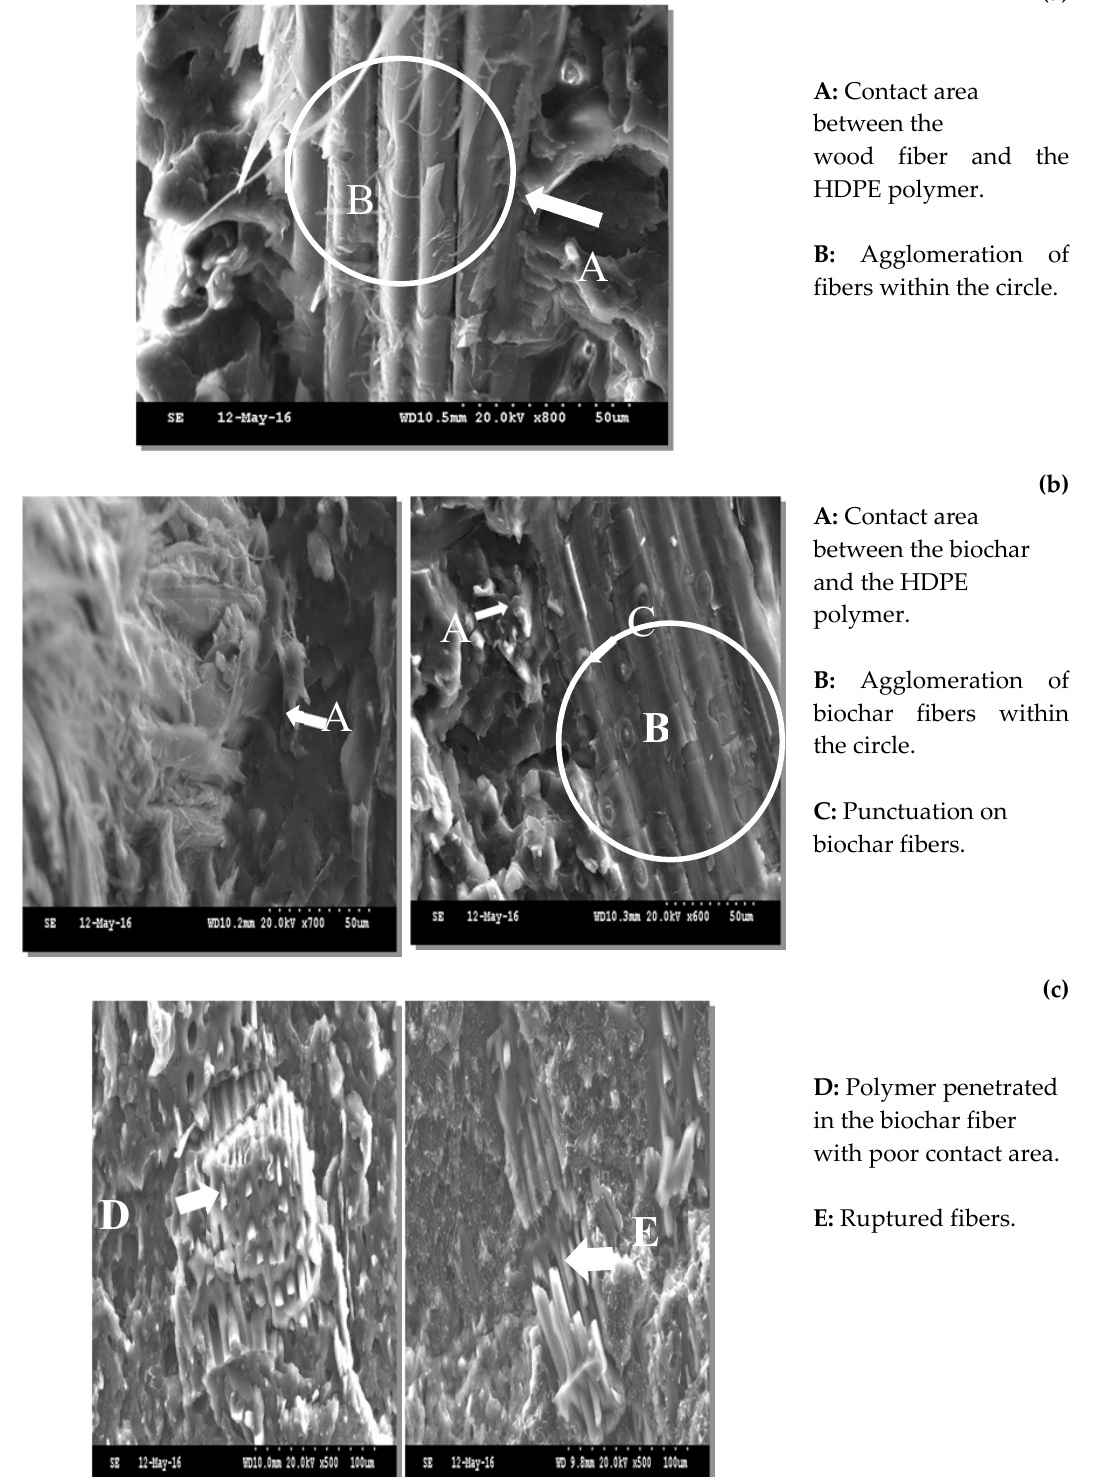
Figure 5. Scanning electron microscope (SEM) images of various HDPE biocomposites: ( a ) WPC with 40% untreated wood fibers; ( b ) BCP with 40% biochar treated at 315 °C; and ( c ) BCP with 40% biochar treated at 400 °C (Left) and 445 °C (Right).